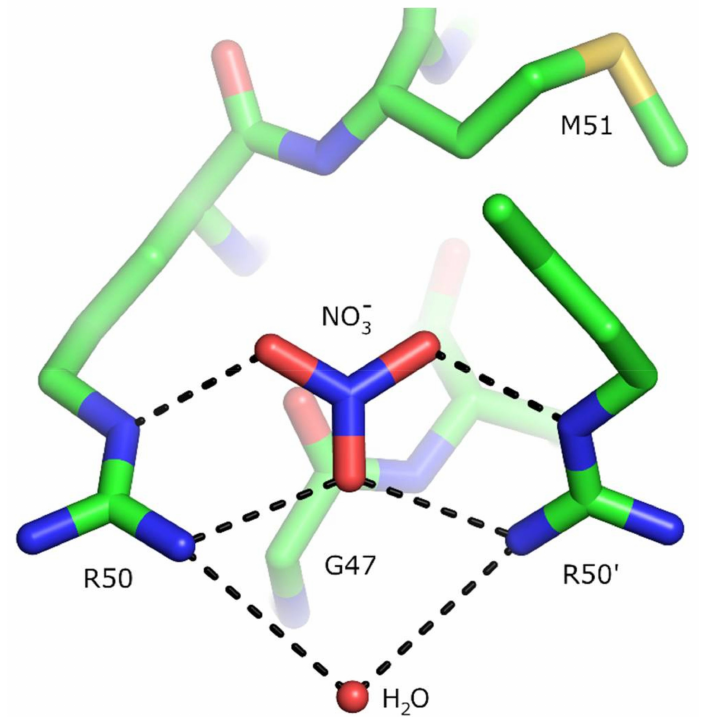
Figure 8. Structure of the nitrate-binding pocket in NarQ [140]. The nitrate is coordinated by Arg50 side chains of the two protomers and stacks with Gly47. The interaction may also be stabilized by interaction between the partially negatively charged carbonyl oxygen atoms of Gly47 and the partially positively charged nitrogen atom of the nitrate ion. G47 and R50 form the G-x-x-R motif conserved among many nitrate-responsive sensor